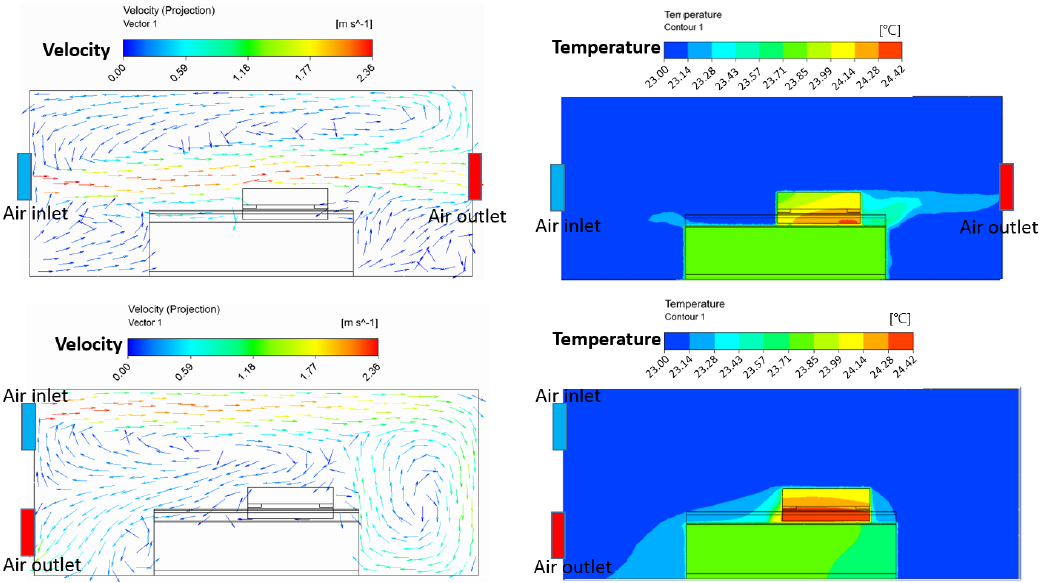
Figure 8. The flow fields and temperature contours in the chamber in the cases where the air inlets and outlets were located, respectively, on opposite sides and on the same side at the inlet air velocity of 2.36 m/s.